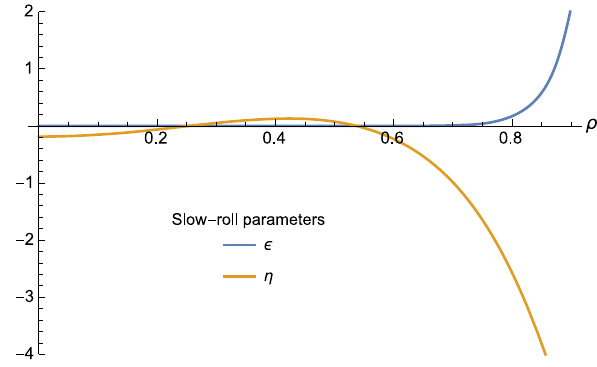
Fig. 6 This plot shows the slow-roll parameters for F = 0, b = 3 / 2, A = 0 . 545, B = 0 . 230, ξ = − 1 . 140 and q = 2 . 121 × 10 −